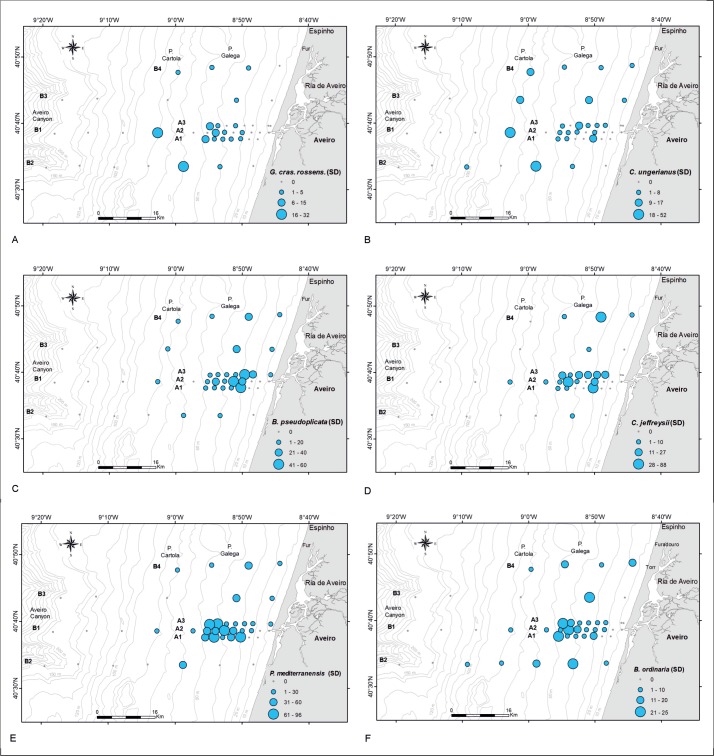
Distribution maps of the main species density of living organisms: A. G. crassa rossensis (G. cras. rossens.); B. C. ungerianus. C. B. pseudoplicata; D. C. jeffreysii; E. P. mediterranensis. F. B. ordinaria. Legend: Cartola—Pontal da Cartola; Galega–Pontal da Galega; Fur–Furadouro; VR—Vouga River. Adapted from Martins et al. [58].